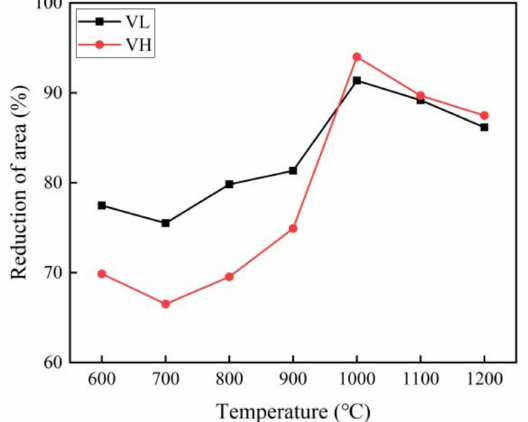
Figure 8. The curves of hot ductility versus temperature of VL and VH steels at a strain rate of 10 − 3 s − 1